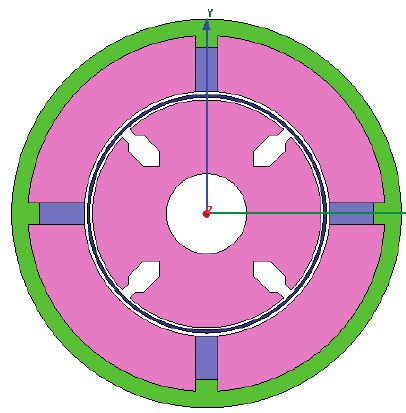
Figure 7. The sensor model established using finite element method.